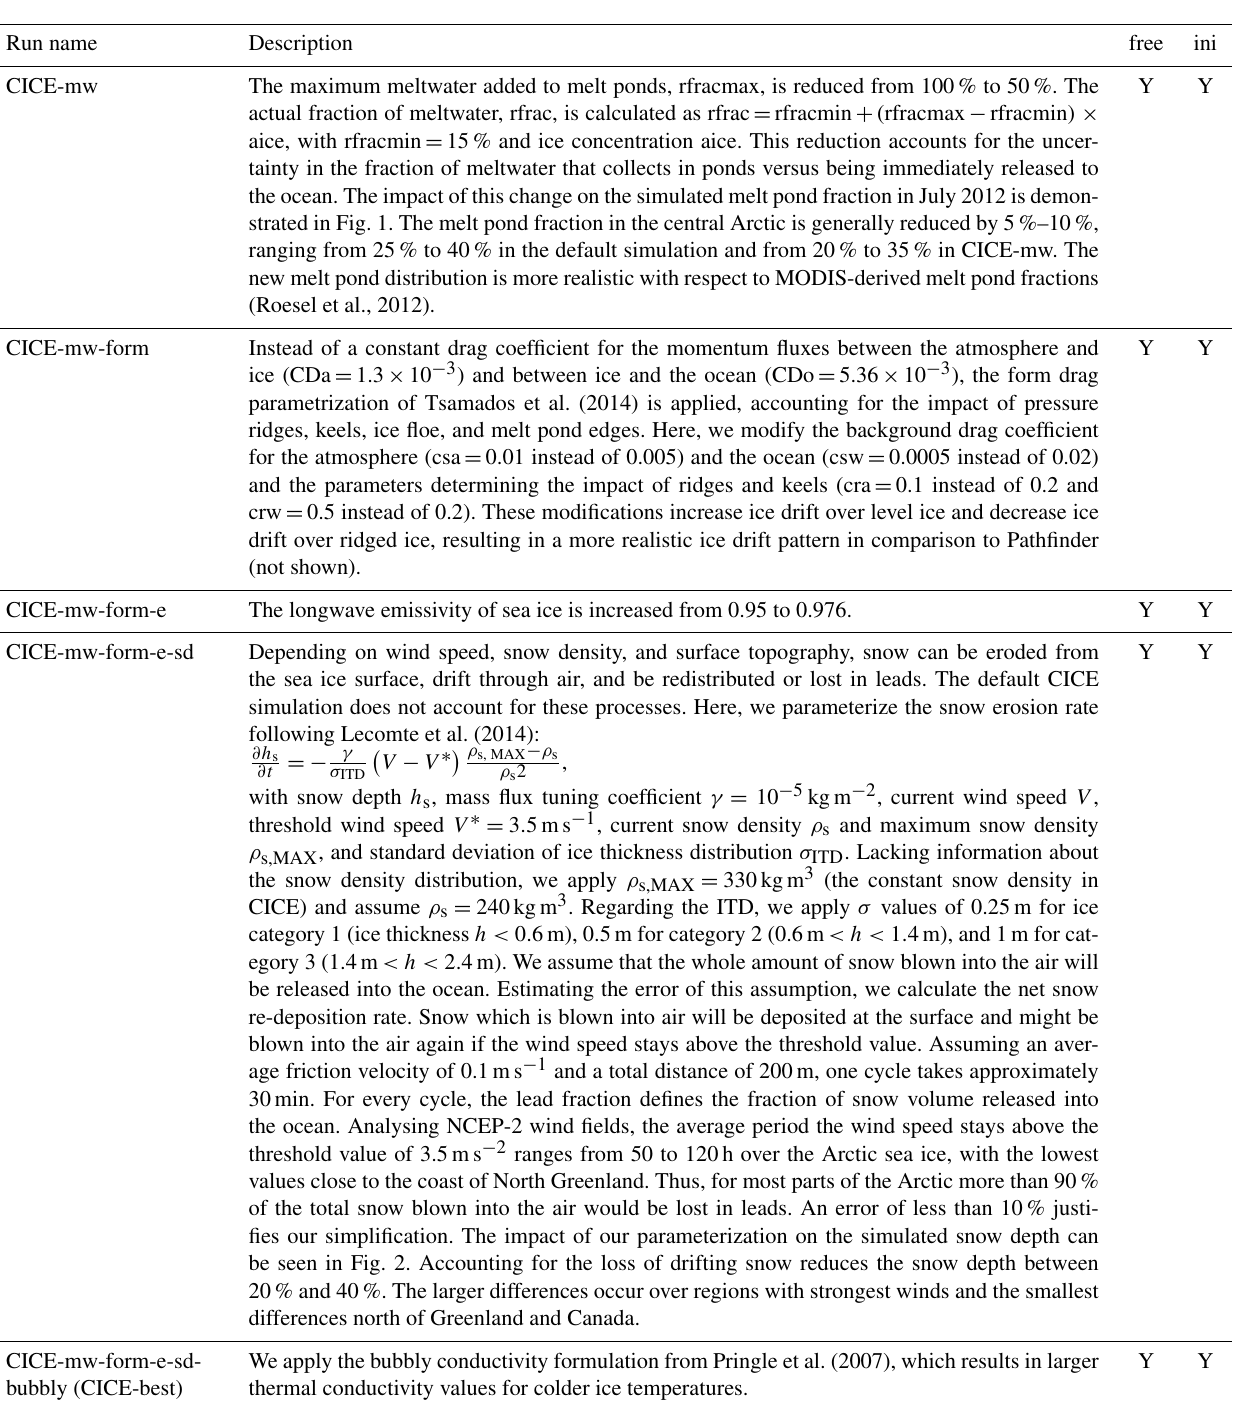
Table 1. Simulations with perturbed physical parameterizations improving sea ice thickness. Note that all model changes are cumulative. “Free” indicates multi-year simulations from 1980 to 2017; “ini” indicates the seven 1-year-long simulations starting in mid-November with CS2 sea ice thickness (2010/11 to